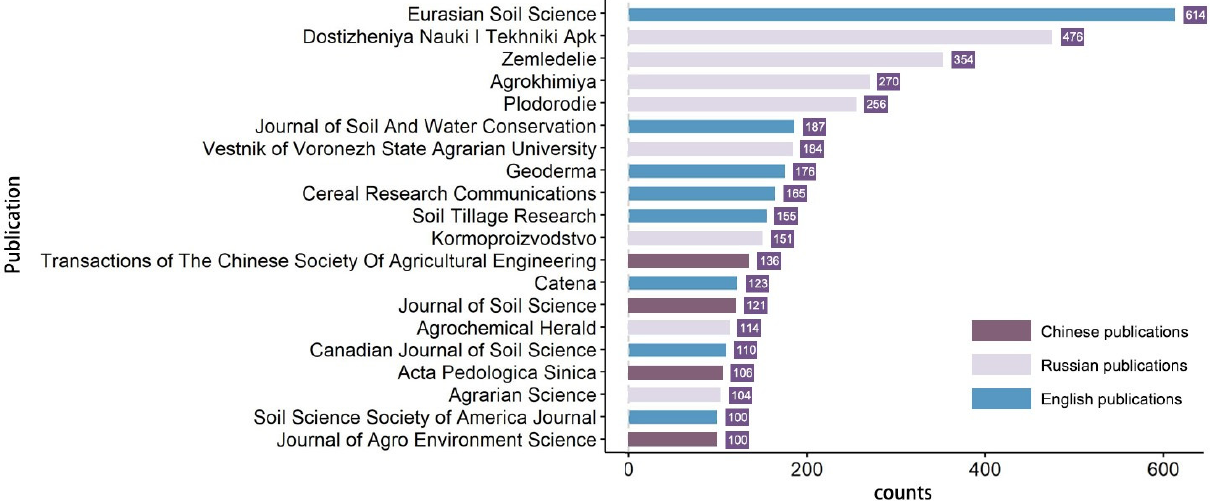
Figure 4. The number of publications. The related literature was searched for in the database from January 2000 to September